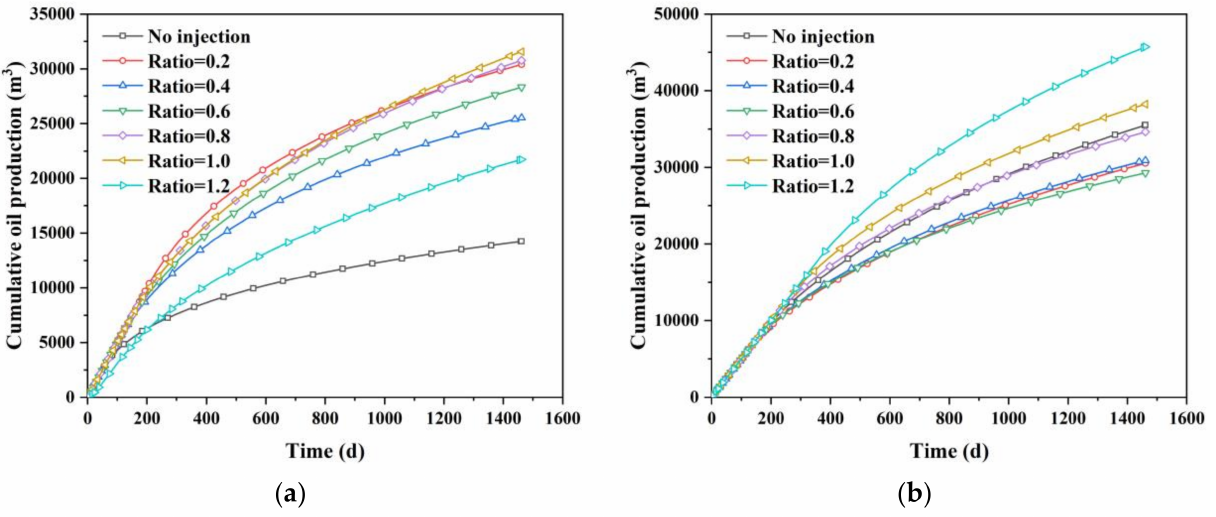
Figure 14. Cumulative oil production of different injection/production ratio, ( a ) parent well; ( b ) infill